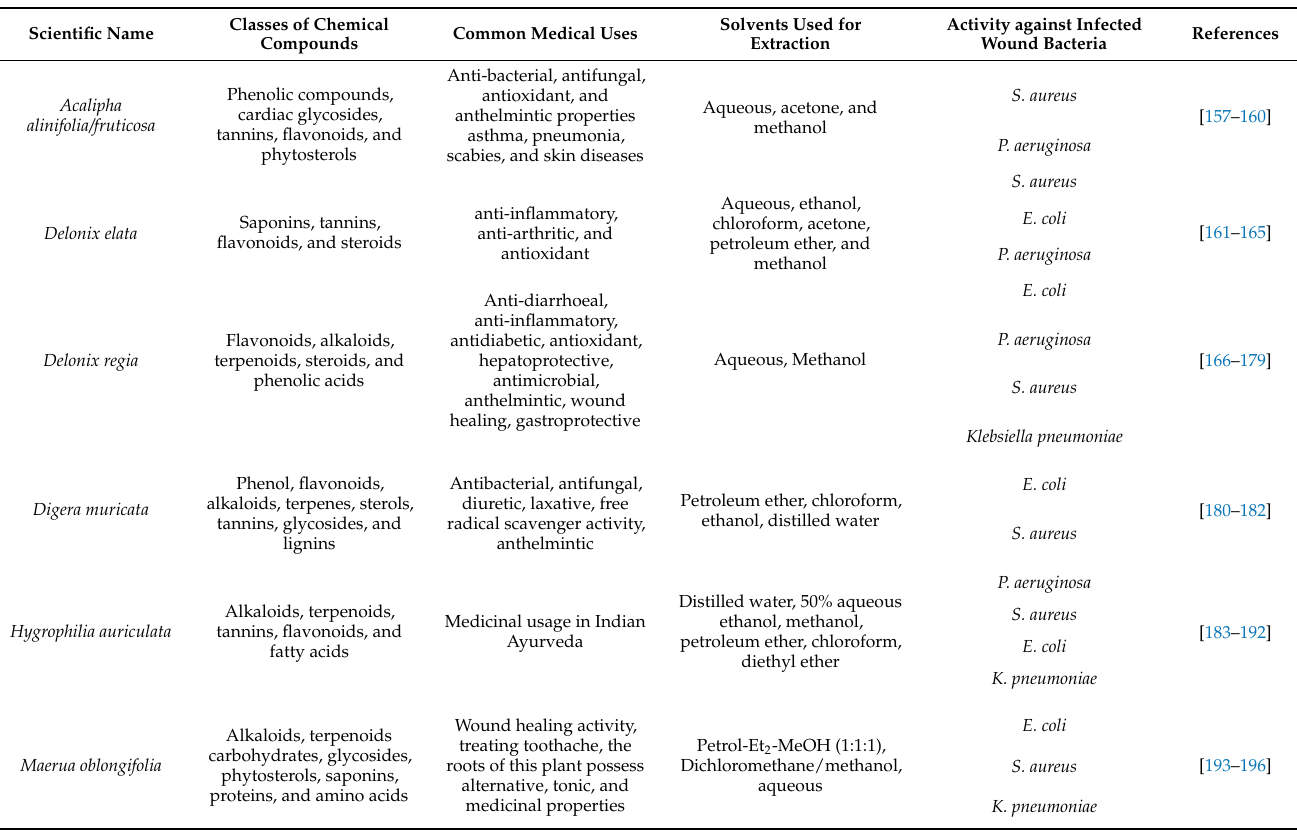
Table 2. Plant species and their activity in wound